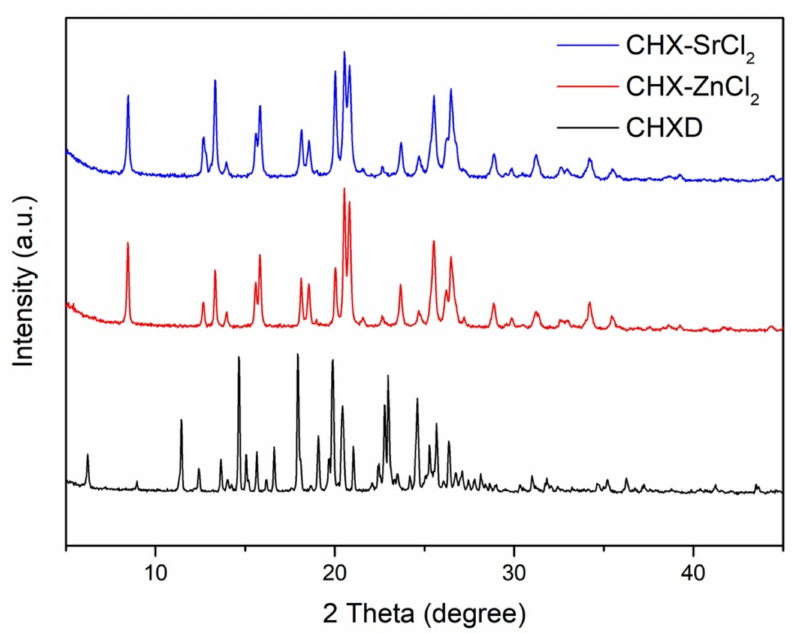
Figure 4. The X-ray diffraction results for CHX-SrCl 2 , CHX-ZnCl 2 , and CHXD